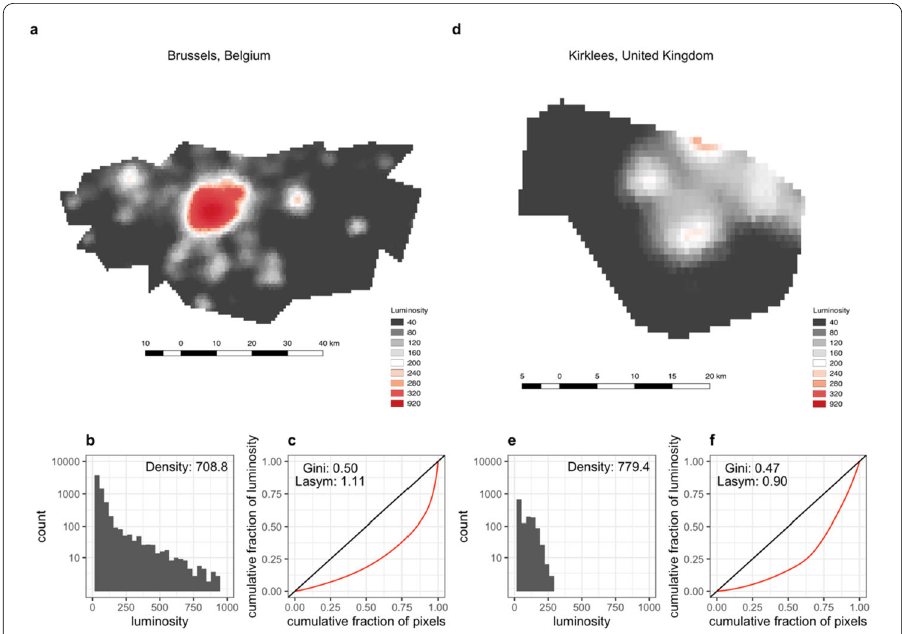
Figure 1 Spatial NTL distributions, luminosity histograms, and Lorenz curves for two cities with comparable density and Gini indices. The data reflects the boundaries defined in 2006. Panels ( a ), ( b ), and ( c ) are NTL distribution, histogram of log-transformed count for luminosity distribution, and Lorenz curve for Brussels, Belgium; panel ( d ), ( e ), ( f ) — Kirklees, United